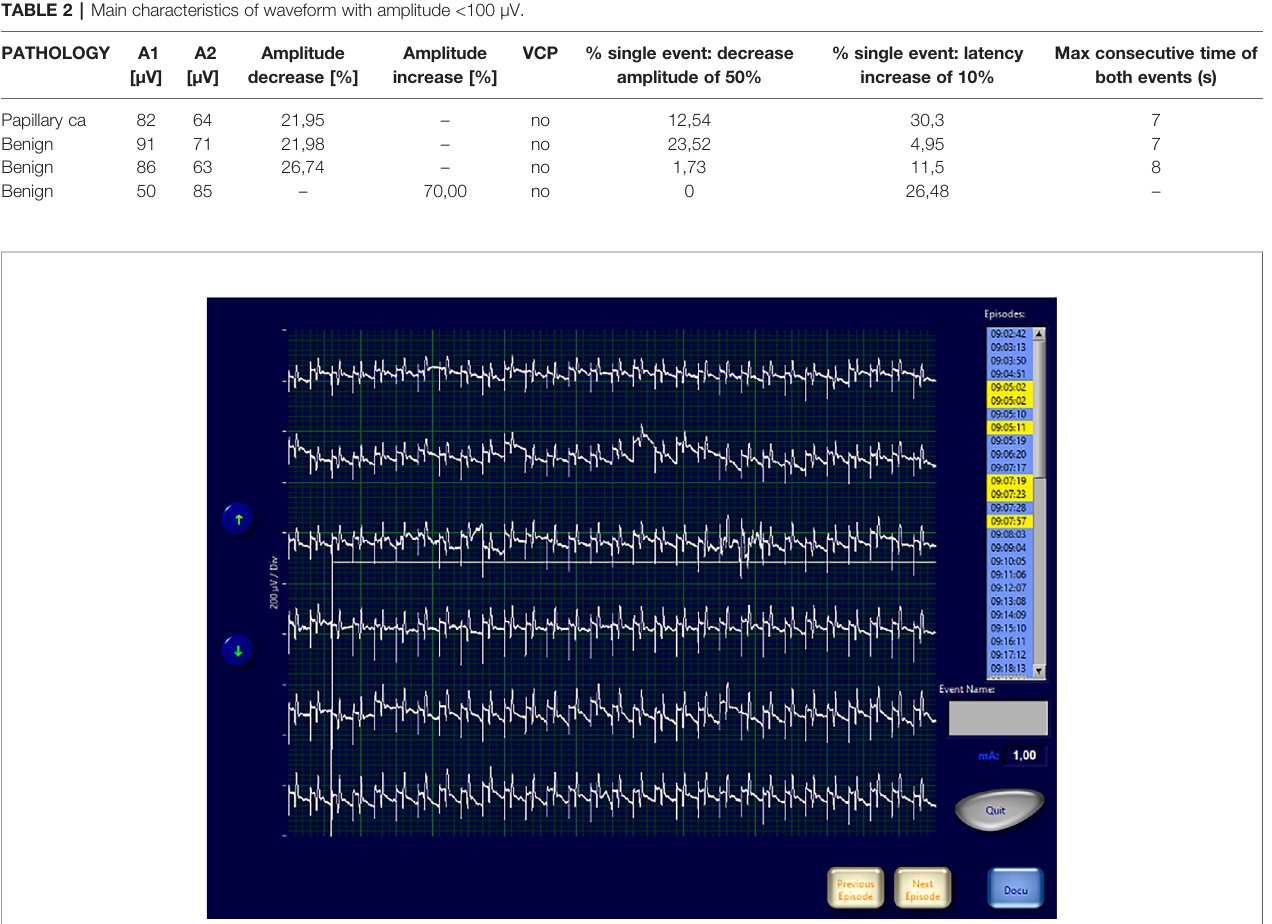
FIGURE 4 | EMG frame that shows EMG waveforms during continuous vagal stimulation with amplitude <100 µV in a patient with normal pre- and postoperative vocal cord function.